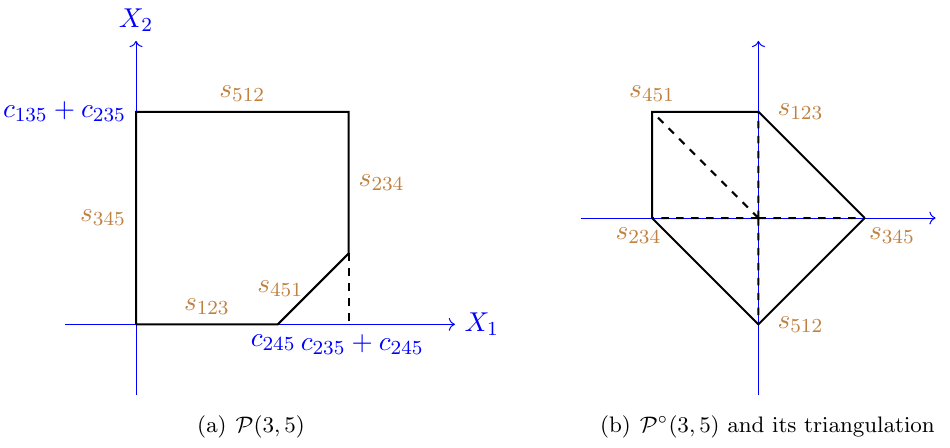
Figure 2 . Polytope P (3 ; 5) and its dual P (cid:14) (3 ; 5) for G + (3 ; 5) =T